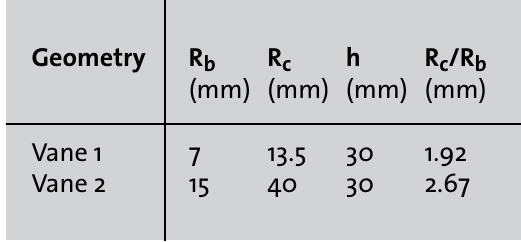
Table 1: Geometrical parameter of vane systems used for sili- con oil